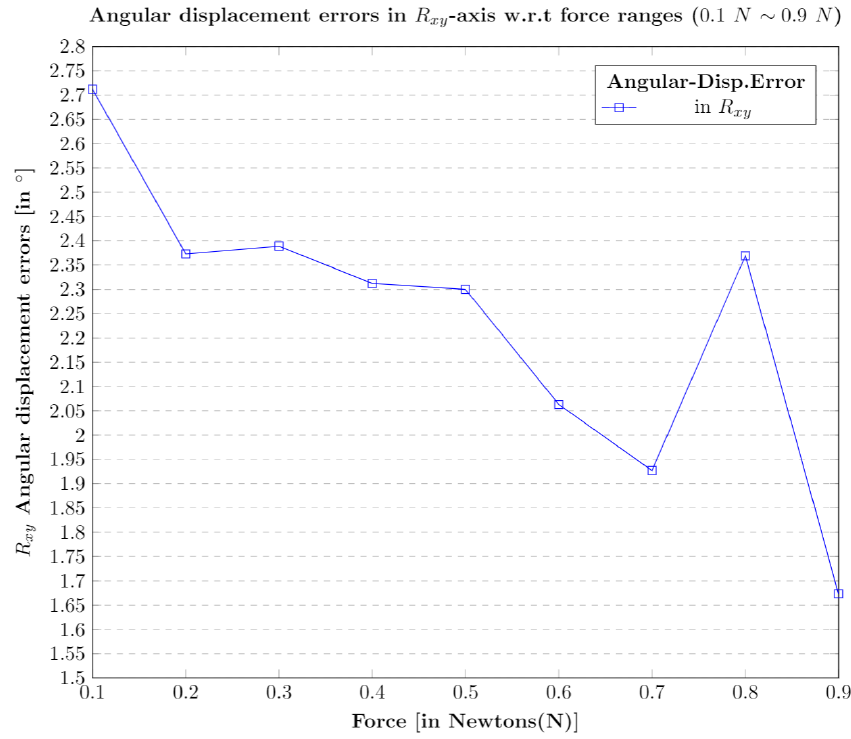
Figure 19. Angular displacement error in R xy axis w.r.t diverse forces (0.1 N ∼ 0.9 N).